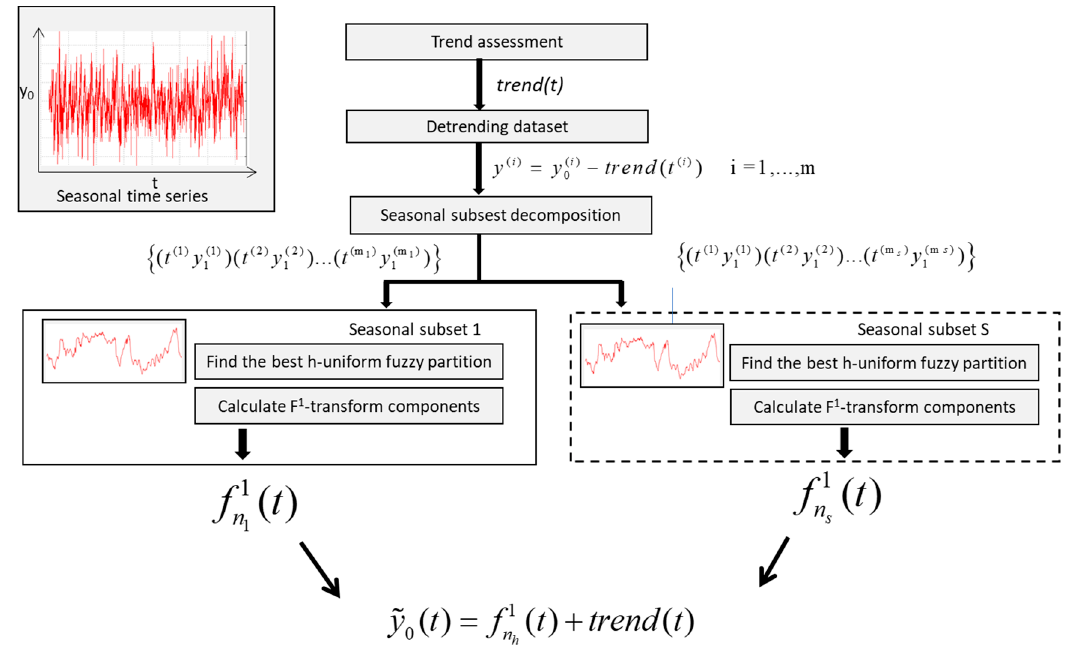
Figure 1. Schema of the TSSF1 algorithm.